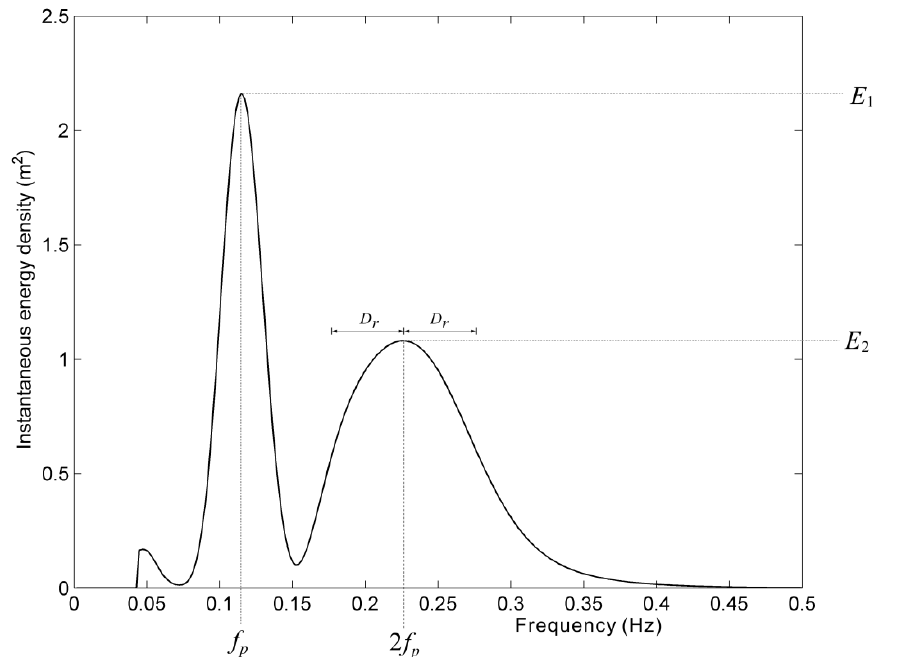
Figure 9. An instantaneous spectrum extracted from the wavelet spectrum of Figure 8a at 97